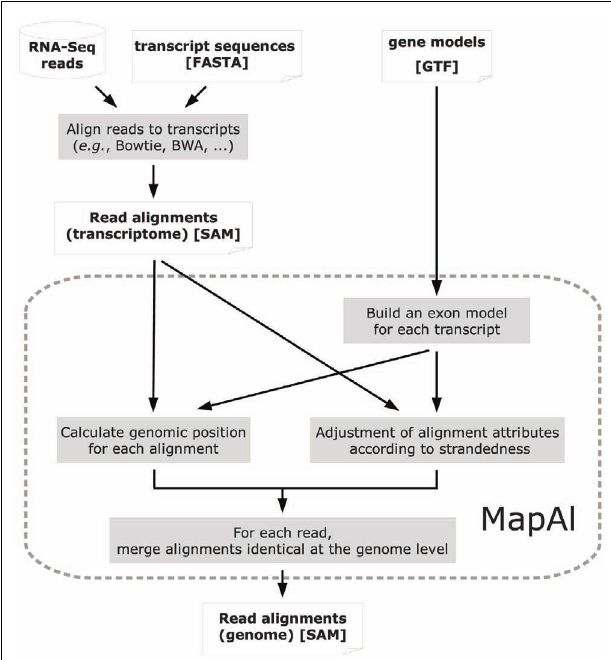
FIGURE 2 |Algorithm structure of MapAl . The flow chart presents the algorithmic structure of the MapAl pipeline.The steps executed by the MapAl script are marked by a dashed rounded rectangle. In particular, reads are first aligned to the known transcript sequences using any aligner supporting the SAM output format.They are then mapped to genomic locations by MapAl by means of the provided gene models. Alignment attributes embedded in the SAM format are adjusted according to strandedness.Then, for each read, alignments identical at the genome level are merged to produce the final genomic alignment file.